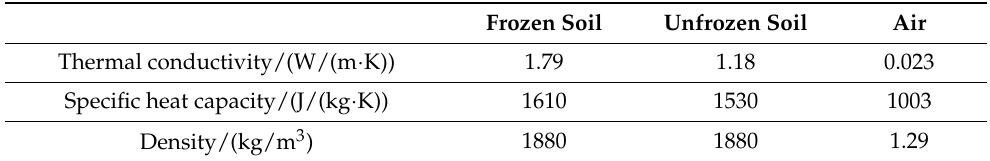
Table 1. The temperature values of the model. Position Temperature/ ◦ C Ambient temperature 20 Initial soil temperature 20 Shield cutterhead 20 Shield shell 60 Freezing pipes According to simulated conditions